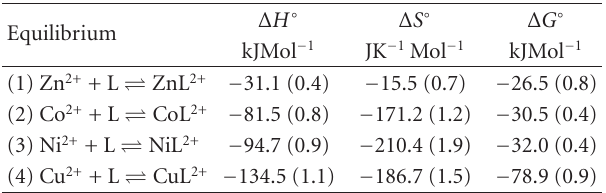
Table 5: Thermodynamic parameters for ML complexes of (BAPP) with 3d divalent metal ions in aqueous solution at 0.1M NaNO 3 at di ff erent temperatures a .